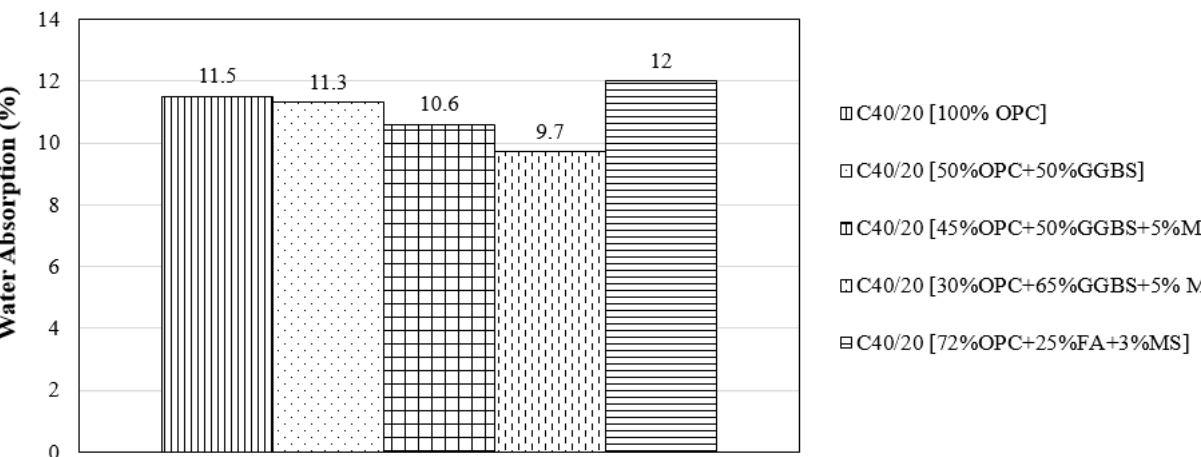
Figure 6. Average 28-day porosity values as per RILEM CPC 11.3 test method for all investigated concrete mixes in study II.